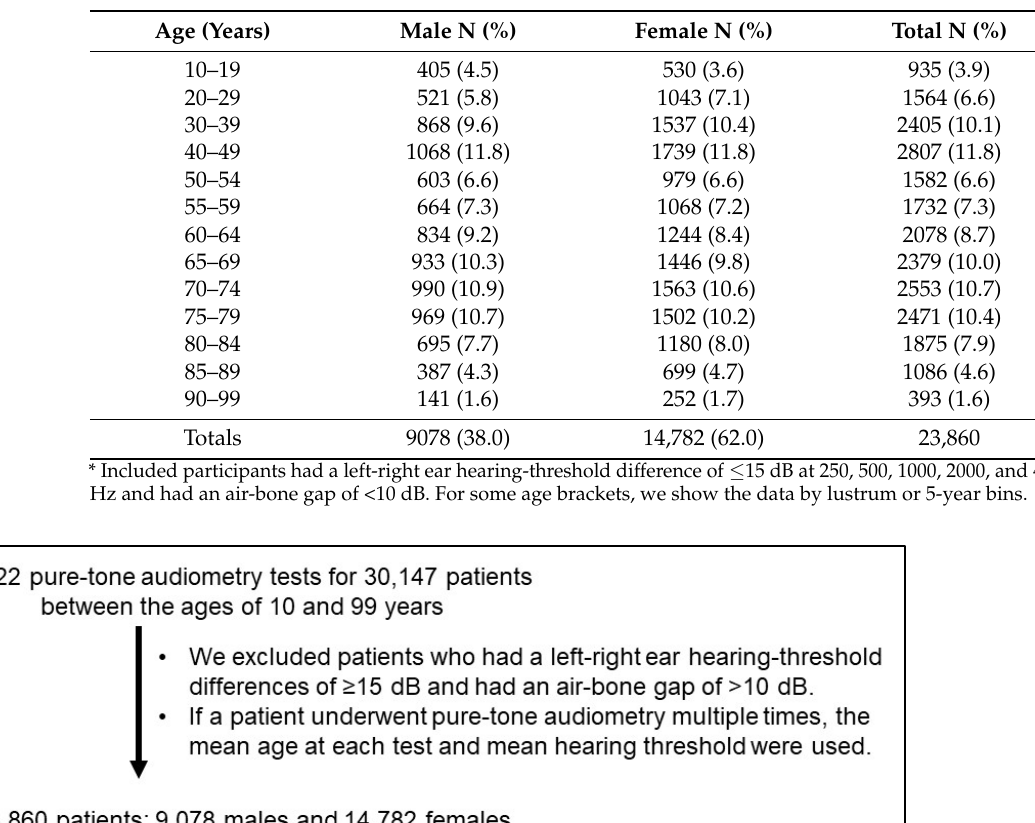
Table 2. Age- and gender-specific distribution of participants *.